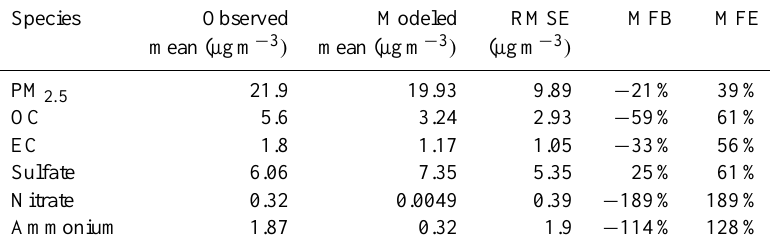
Table 7. Statistical performance evaluation for PM 2 . 5 , OC, EC and particulate sulfate, nitrate and ammonium at USJ for the simulation A4. Species Observed Modeled RMSE MFB MFE mean (µgm − 3 )